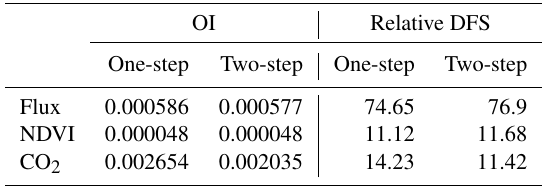
Table 4. Observation influence and relative DFS statistics of each data stream for the joint assimilation experiments F + VI + CO2 and F + VI + CO2-2steps. OI Relative DFS One-step Two-step One-step Two-step Flux 0.000586 0.000577 74.65 NDVI 0.000048 CO